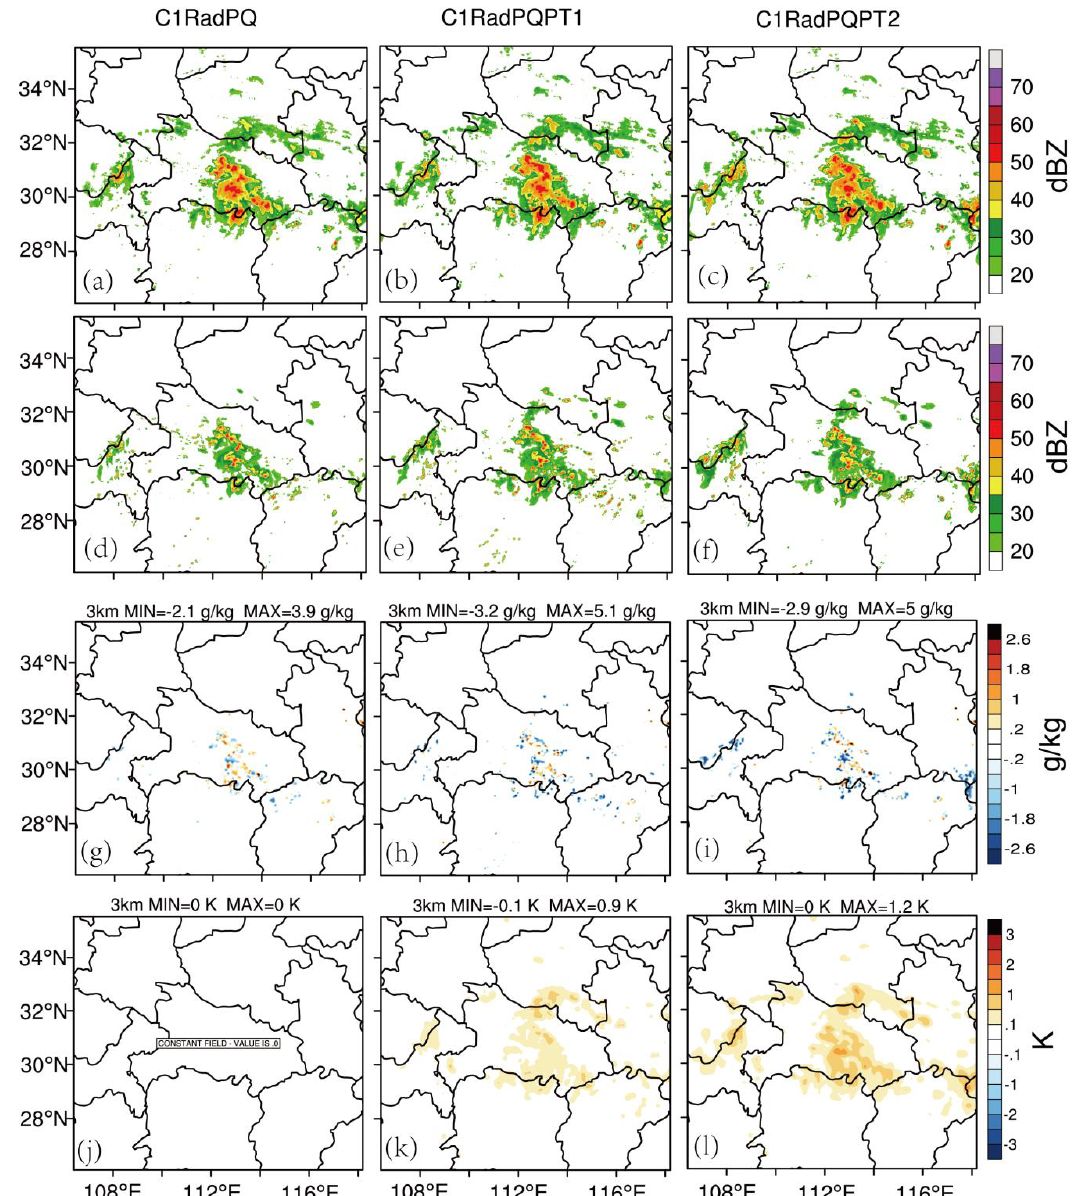
Figure 5. The analysis composite reflectivity (first row, a – c ), background simulation composite reflectivity (second row, d – f ), analysis increments of qv (third row, g – i ), and analysis increments of θ (fourth row, j – l ) for C1RadPQ, C1RadPQPT1 and, C1RadPQPT2 at 3 km AGL, 0300 UTC, 30 June 2018.